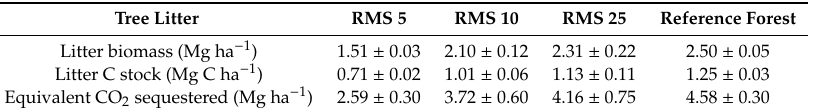
Table 3. Estimation of litter carbon stock in reclaimed chronosequence and reference forest site.